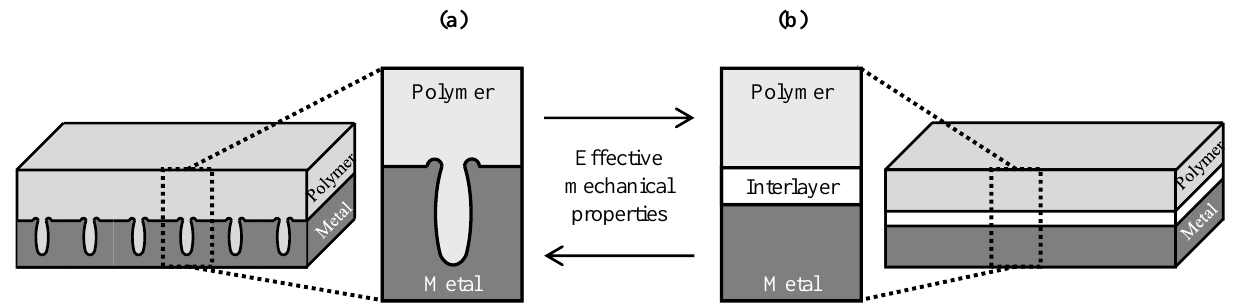
Figure 6. RVE model (a) and cohesive zone model approach for laser-based hybrid joints. Figure 6. ( a ) RVE model and ( b ) cohesive zone model approach for laser-based hybrid